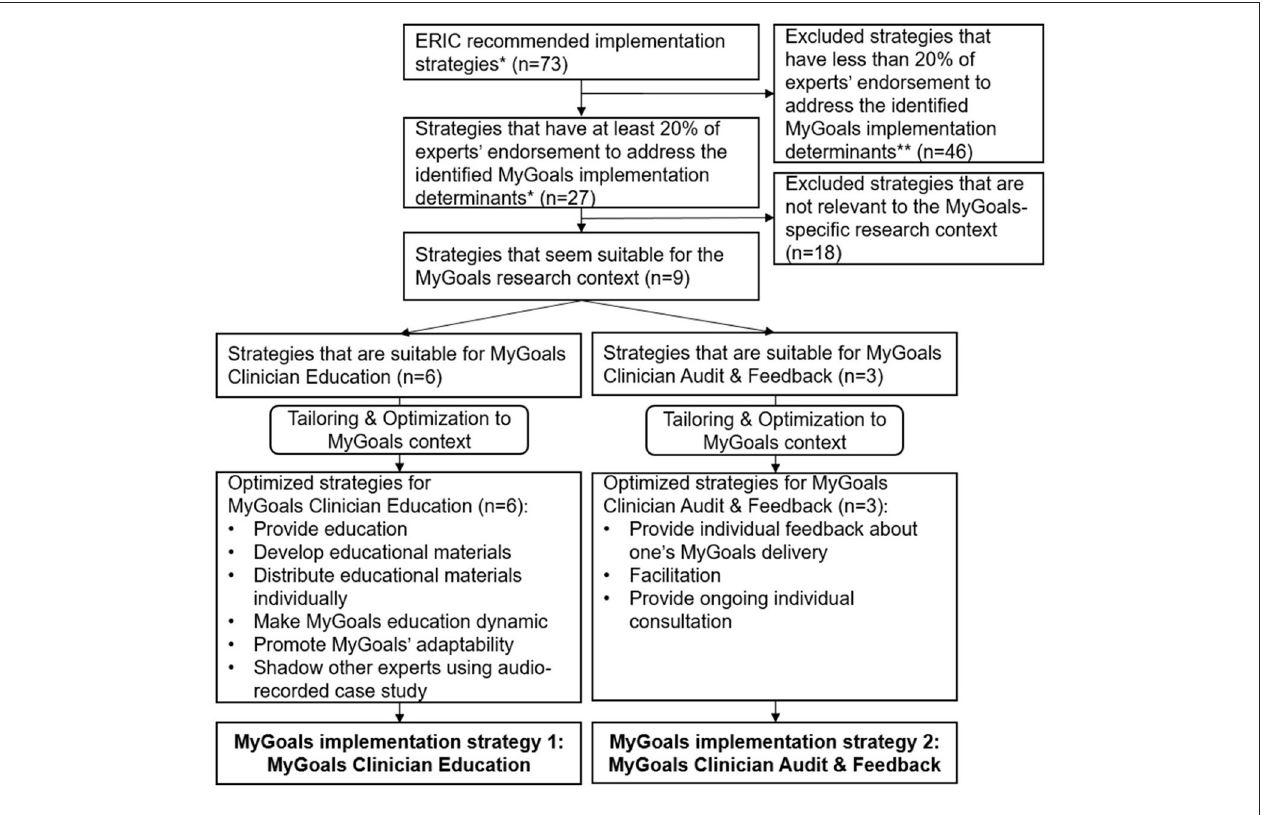
FIGURE 2 | MyGoals implementation strategy selection and optimization process. *Powell et al. (28). **The identified determination determinates included MyGoals’ evidence strength and quality, MyGoals’ relative advantage, and OT’s knowledge, awareness, skills, self-efficacy and outcome